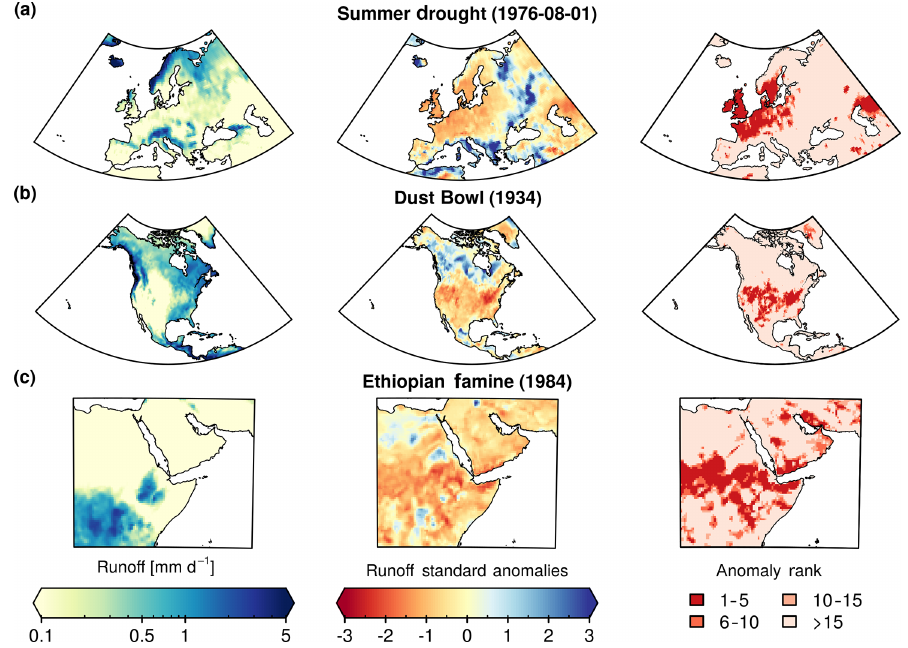
Figure 12. Three extreme drought events as reconstructed by GRUN. (a) European summer drought in 1976. (b) US Dust Bowl in 1934. (c) Ethiopian famine in